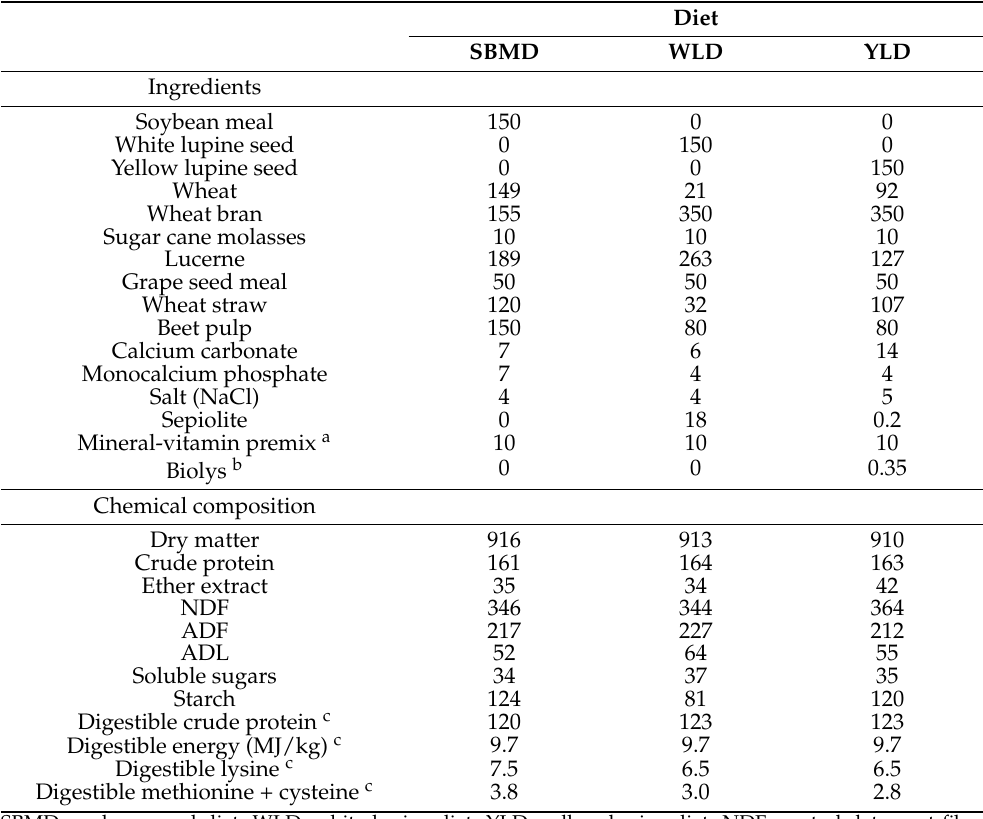
Table 1. Ingredients and chemical compositions (g/kg as-fed basis) of the experimental diets (Adapted with permission from Ref. [18]. 1 August 2021, Elsevier). Diet SBMD WLD